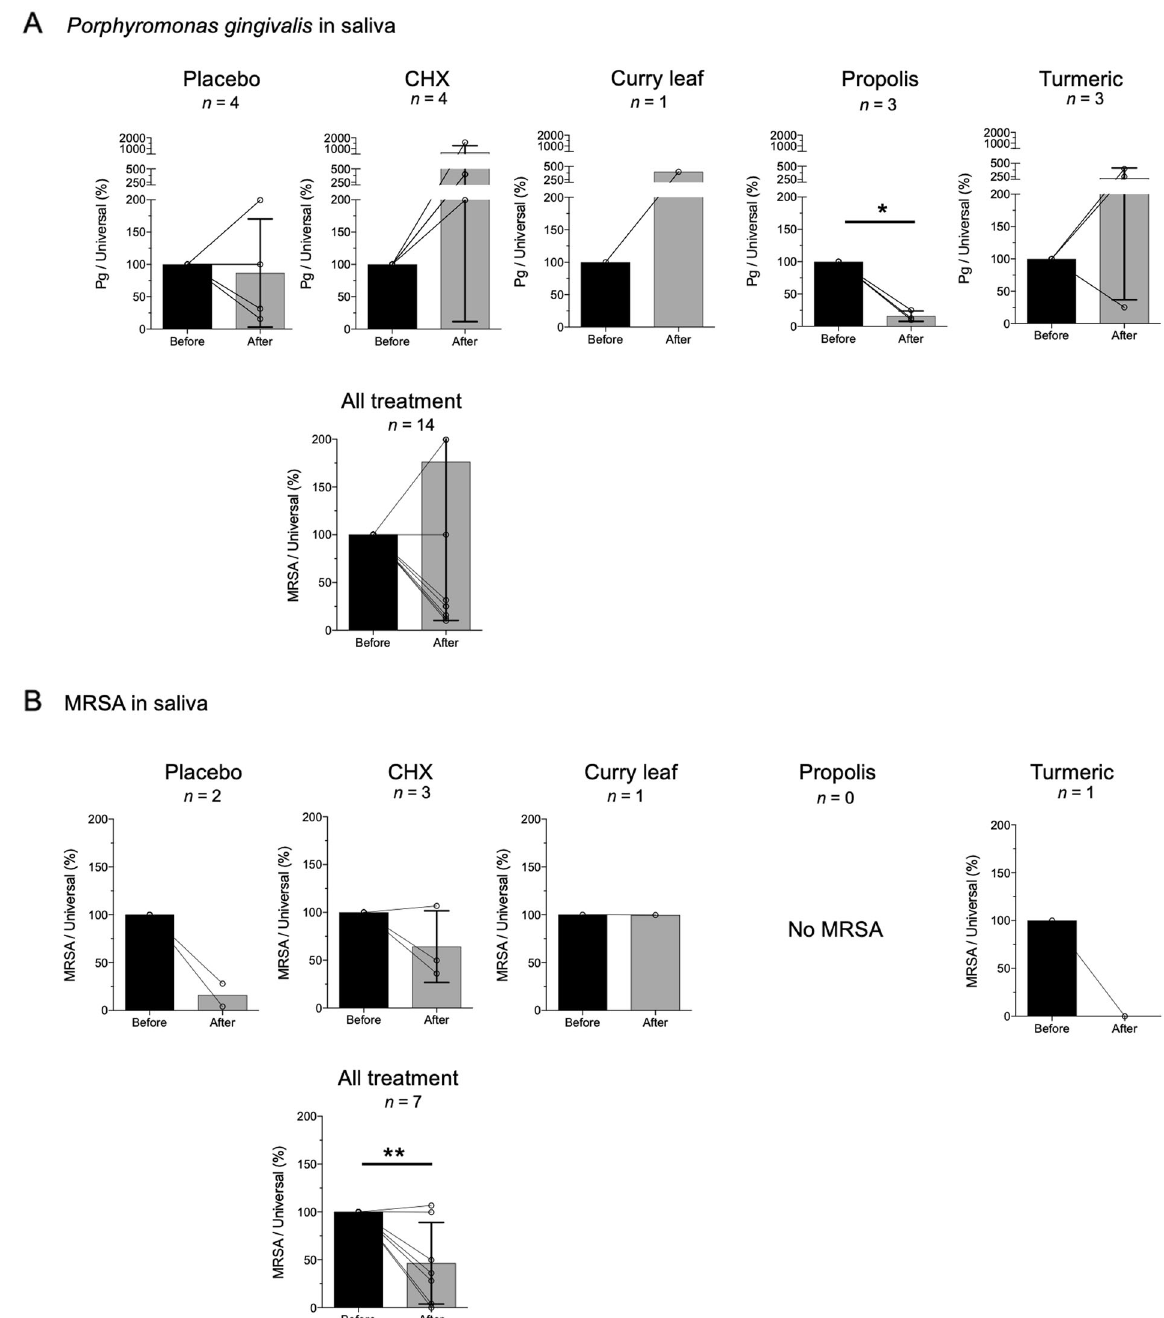
Fig. 2 Effect of oral gels with different ingredients on bacteria in saliva. Transition of the numbers of A P. gingivalis and B MRSA before and after the intervention was assessed by quantitative real-time PCR. The copy number of each species-speci fi c gene was normalized by that of the universal 16S-rRNA gene. The normalized values at baseline (before) and post-intervention (after) were standardized as 100% and the ratio (%) to the baseline value, respectively, then were plotted as open circles. The open circles before and after the intervention for each individual are connected with a line. The average with SD of “ before ” and “ after ” are indicated as black and gray bars with lines, respectively. * P ≤ 0.05; ** P ≤ (14.0%, 7/25). S. marcescens and E. coli were not detected in saliva Microbiological assessment of saliva showed that the total of any subjects. number of oral bacteria was not in fl uenced by topical application It is interesting to note that the number of P. gingivalis organisms of gel, irrespective of the ingredients (Supplementary Fig. S2). was decreased in the propolis gel treatment group ( P ≤ 0.05, Fig. 2A), Detection frequencies of each bacterium at baseline were but not in the others (data not shown). Moreover, despite the low different: high frequency for F. nucleatum (100%, 25/25) and T. detection frequency of MRSA, when data from all subjects were forsythia (96%, 24/25); moderate frequency for P. gingivalis (60%, analyzed together, MRSA carriage in saliva was shown to be reduced 15/25), T. denticola (60%, 15/25), and C. albicans (64%, 16/25); low ( P ≤ 0.01, Fig. 2B). frequency for A. actinomycetemcomitans (8%, 2/25) and MRSA